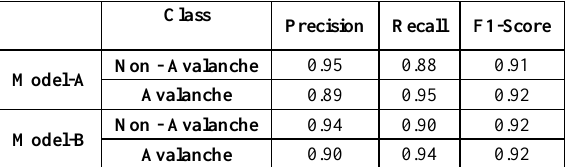
Table 3. Overall precision, recall, and F1-Score of the RF models.